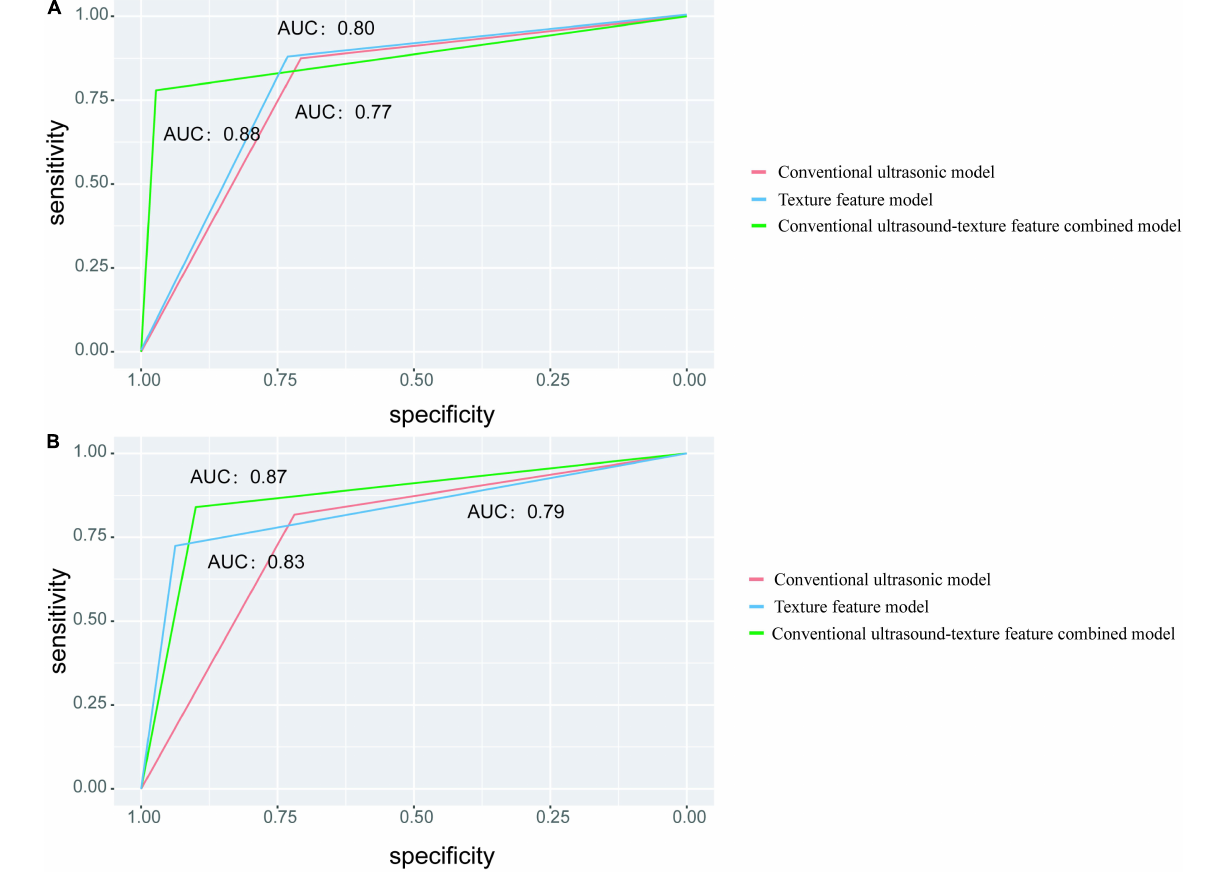
FIGURE 4 | Different models for predicting classification performance. (A) The ROC curve with the AUC value for the training set. (B) The ROC curve with the AUC values for the testing